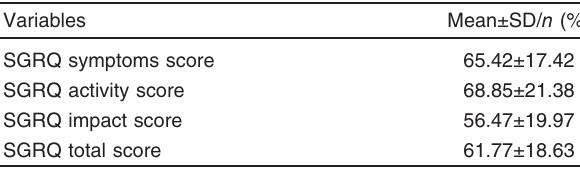
Table 3 St George ’ s Respiratory Questionnaire scores in